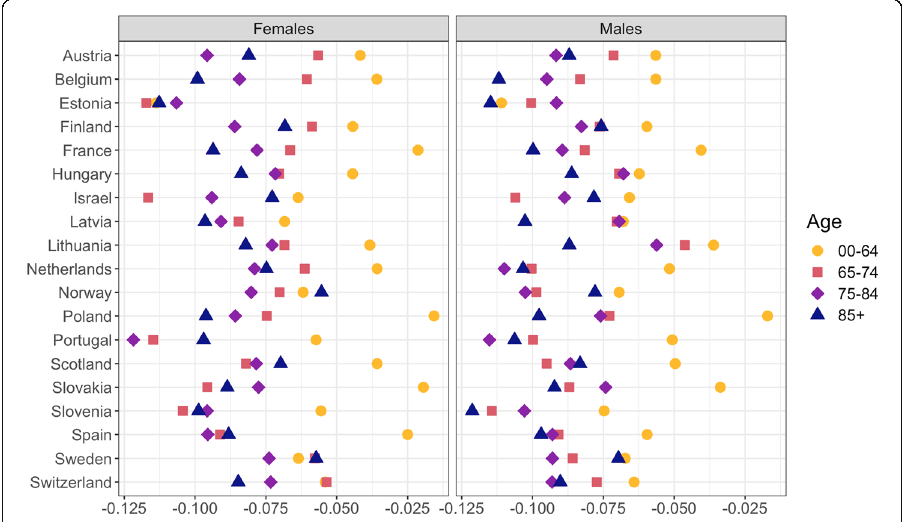
Fig. 1 Loadings of principal component